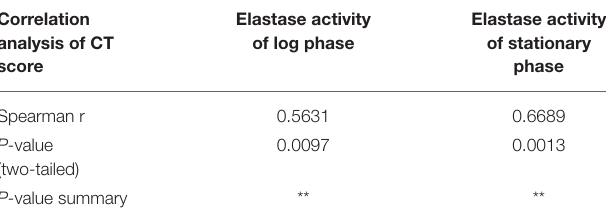
TABLE 2 | Spearman correlation analysis of Lund-Mackay Computed Tomography (CT) scores with elastase activity at log phase or stationary phase. Correlation analysis of